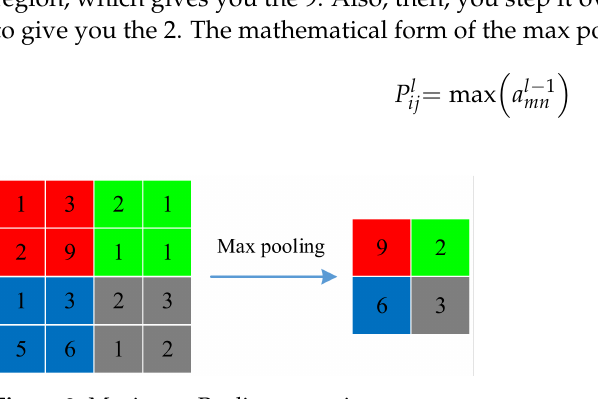
Figure 2. Maximum Pooling operation.